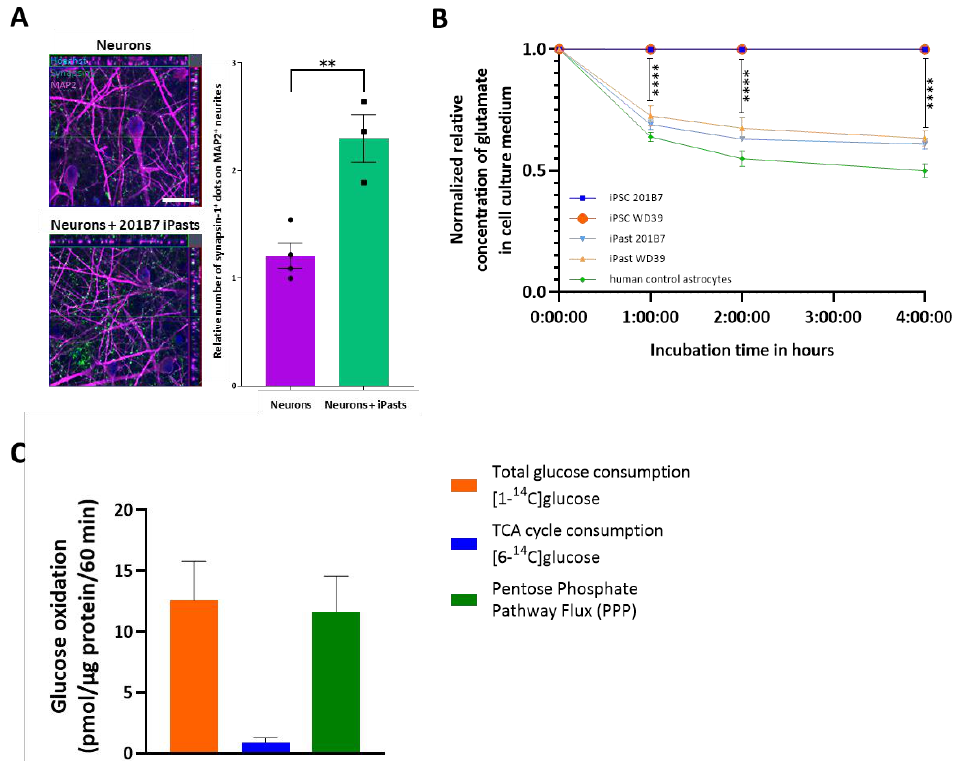
Figure 7. iPasts are Functional Cells. ( A ) Healthy cortical neurons in indirect co-culture with iPasts. Neurons were immunostained for Synapsin-1 (green) and MAP2 (magenta). Histograms show the analysis of Synapsin-1+ dots in MAP2+ neurons. n = 3 independent experiments. Scale bar: 20 µm. Individual data are shown as • and ▪ and error bars are mean ± SEM. Statistical test used: Student’s t -test. ** indicates p -value (p) < 0.01. ( B ) Glutamate uptake of iPast lines was compared to iPSCs (negative control) and human control astrocytes (positive control) at 1, 2 and 4 h after adding glutamate at 250 µM. n = 9 passages. Statistical test used: Mann-Whitney test. **** indicates p -value (p) < 0.0001. ( C ) Rates of 14 CO 2 production from the oxidation of [1- 14 C]-glucose and [6- 14 C]-glucose and rate of the PPP in iPasts. Values are means ± SEM for quadruplicate flasks.